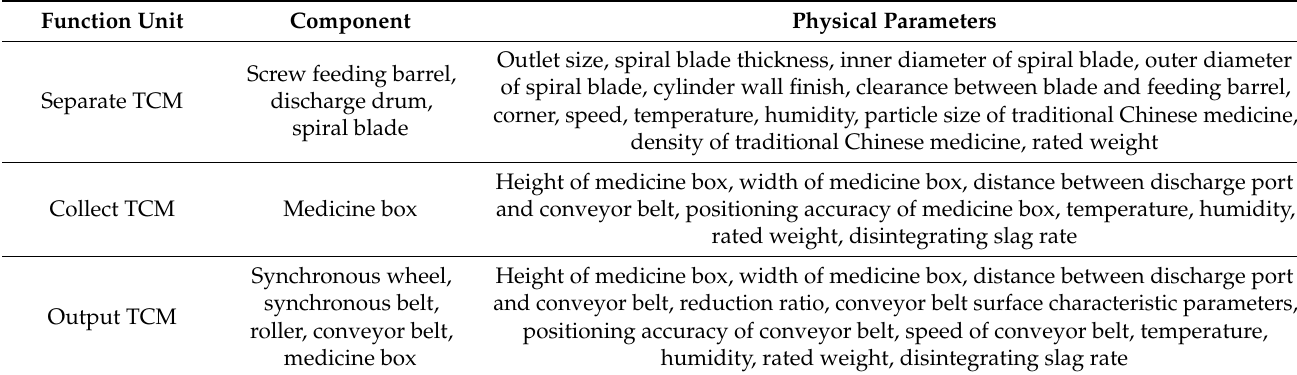
Table 1. Corresponding relationship between function units and physical